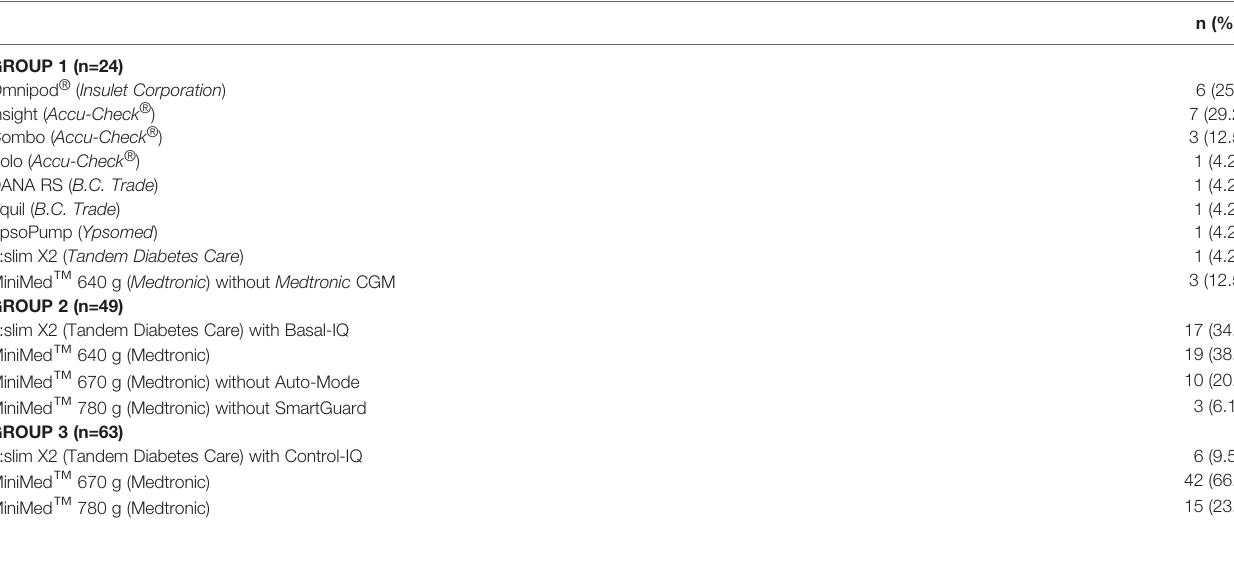
TABLE 1 | Different types of insulin pumps used in our